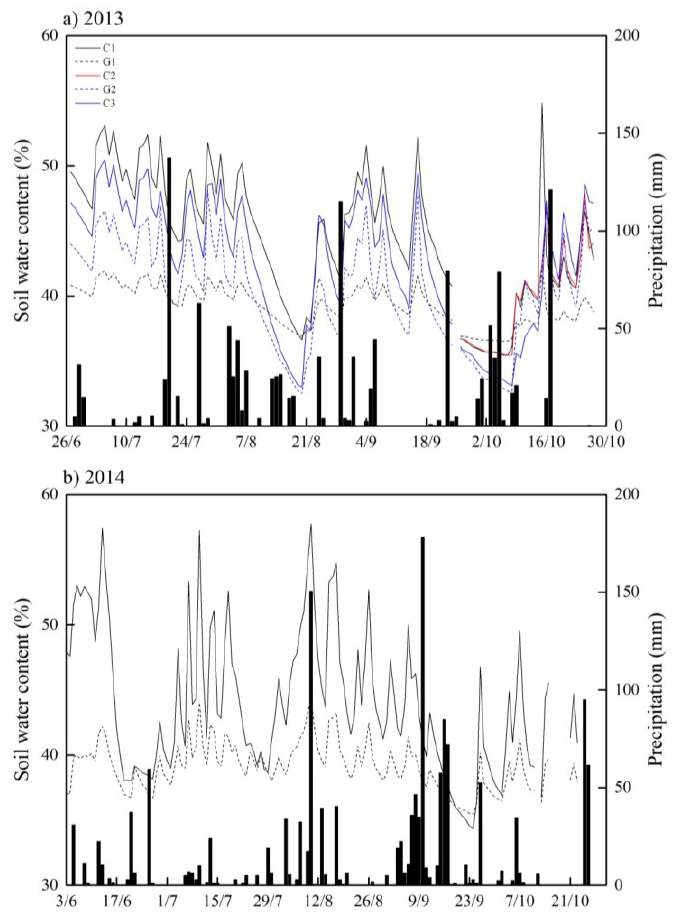
Figure 5. Temporal changes in soil water content ( W ) at a depth of 5 cm during the growing seasons of 2013 ( a ) and 2014 ( b ). Precipitation data were provided by Miboro weather station.